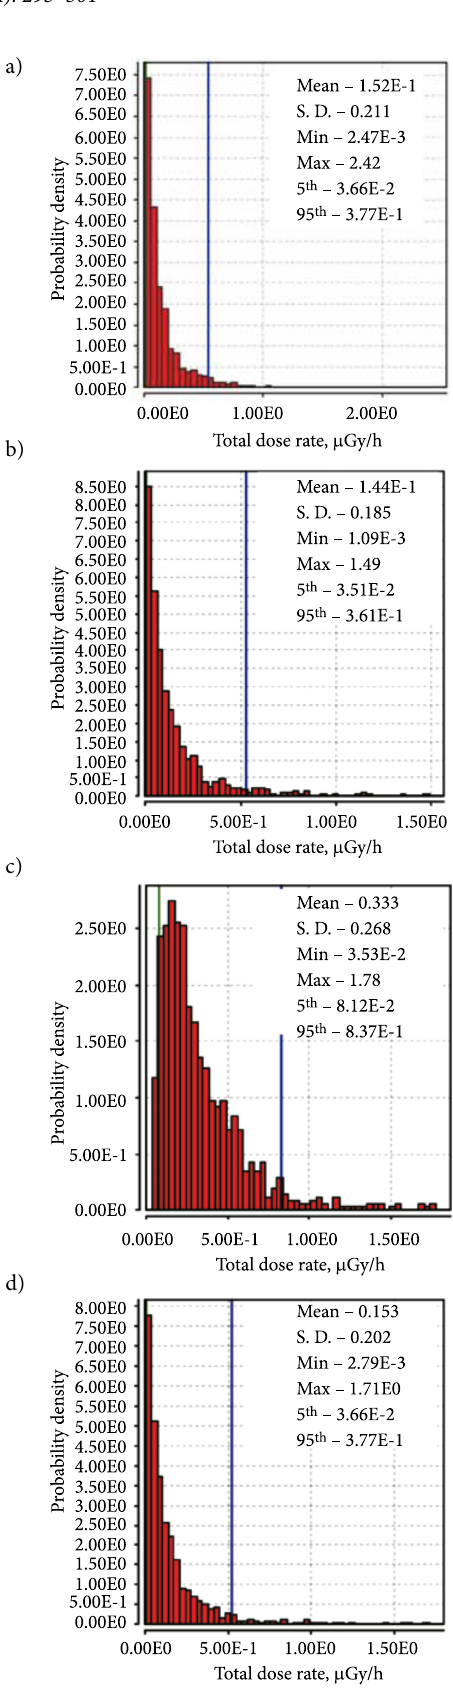
Fig. 3. Examples of estimated total dose rates to terrestrial reference organisms due to 238 U only: a) detritivorous invertebrate, b) flying insects, c) lichen & bryophytes, and d) soil invertebrate